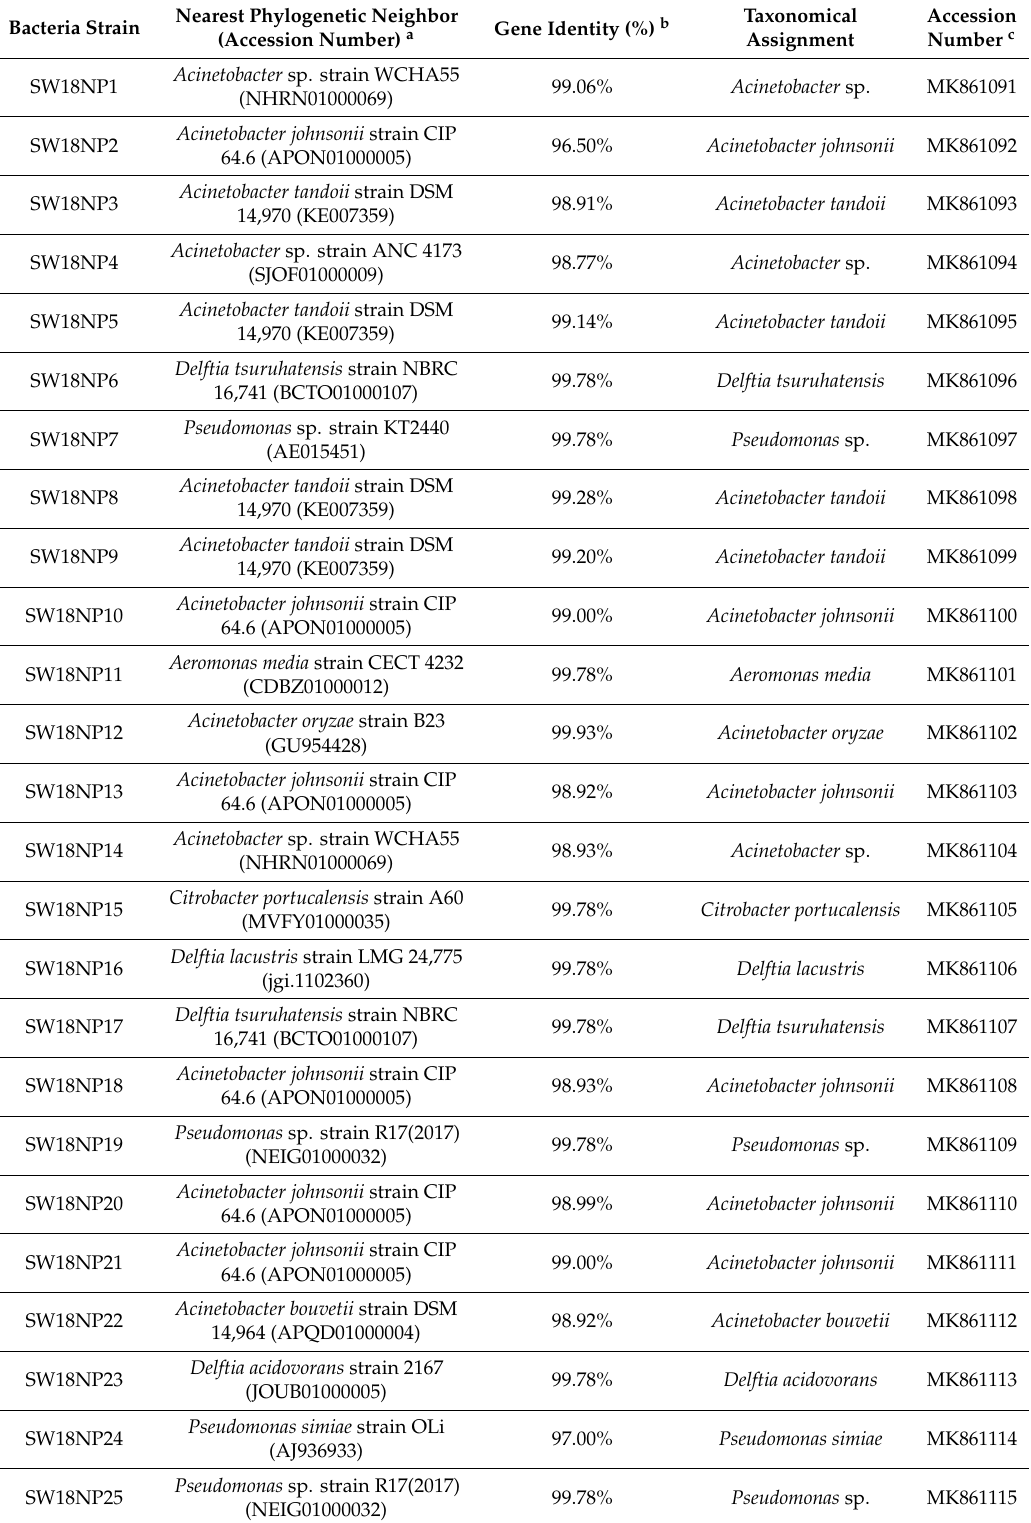
Table 1. The online BLAST results of 16S rRNA gene sequences for the 25 aerobic denitrifying phosphate accumulating bacteria (ADPB) strains in the activated sludge of the A 2 O aerobic biological